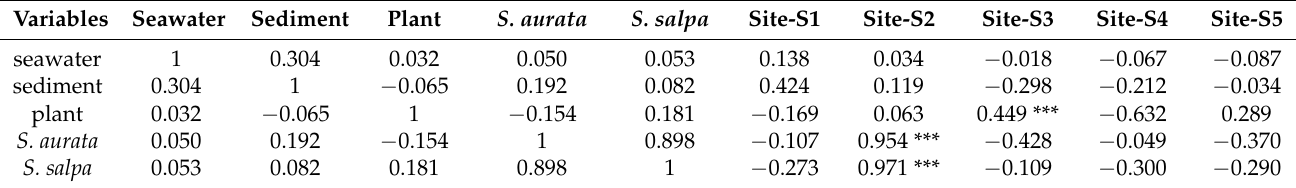
Figure 4. Correlation circle between samples (seawater, sediment, plant) and sites. Table 2. Matrix correlation of Person between Hg concentration in samples and sites